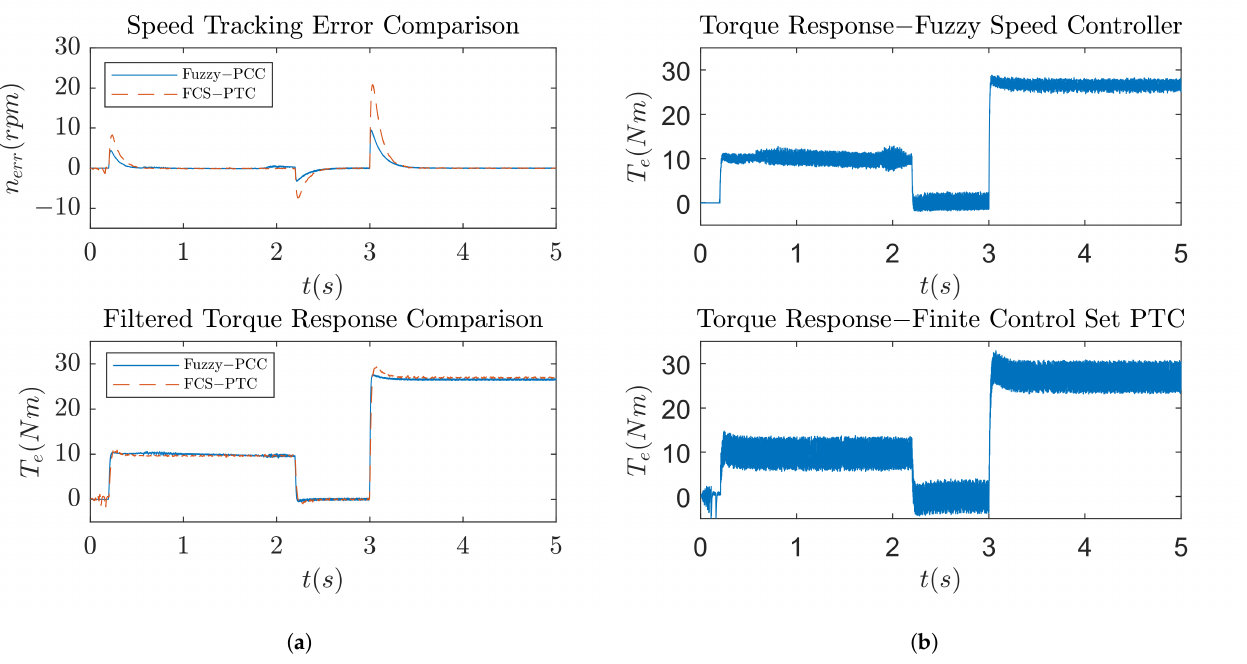
Figure 15. System response comparison between proposed method and FCS-PTC method. ( a ) Speed tracking error and filtered torque response. ( b ) Unfiltered torque